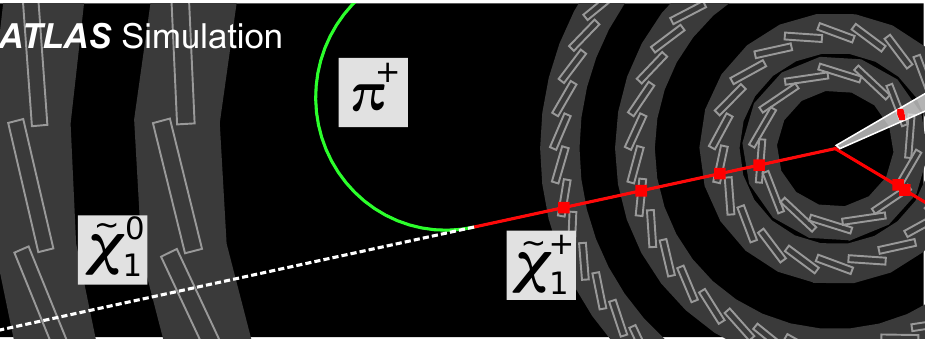
Figure 1 . Illustration of a pp ! ~ (cid:31) + 1 ~ (cid:31) (cid:0) 1 + jet event, with long-lived charginos. Particles produced in pile-up pp interactions are not shown. The ~ (cid:31) + 1 decays into a low-momentum pion and a ~ (cid:31) 0 1 after leaving hits in the four pixel layers (indicated by red